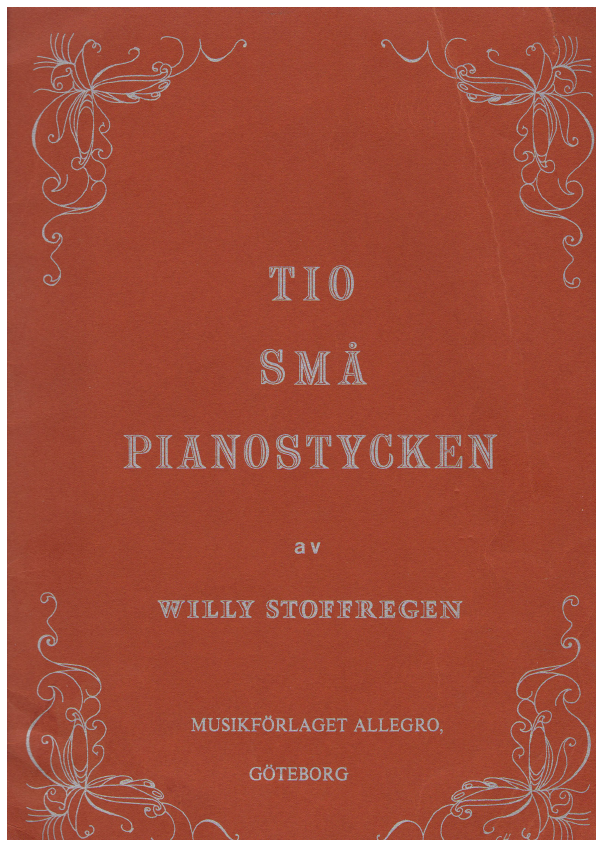
Figure 3. Title page of piano pieces composed by Stoffregen.